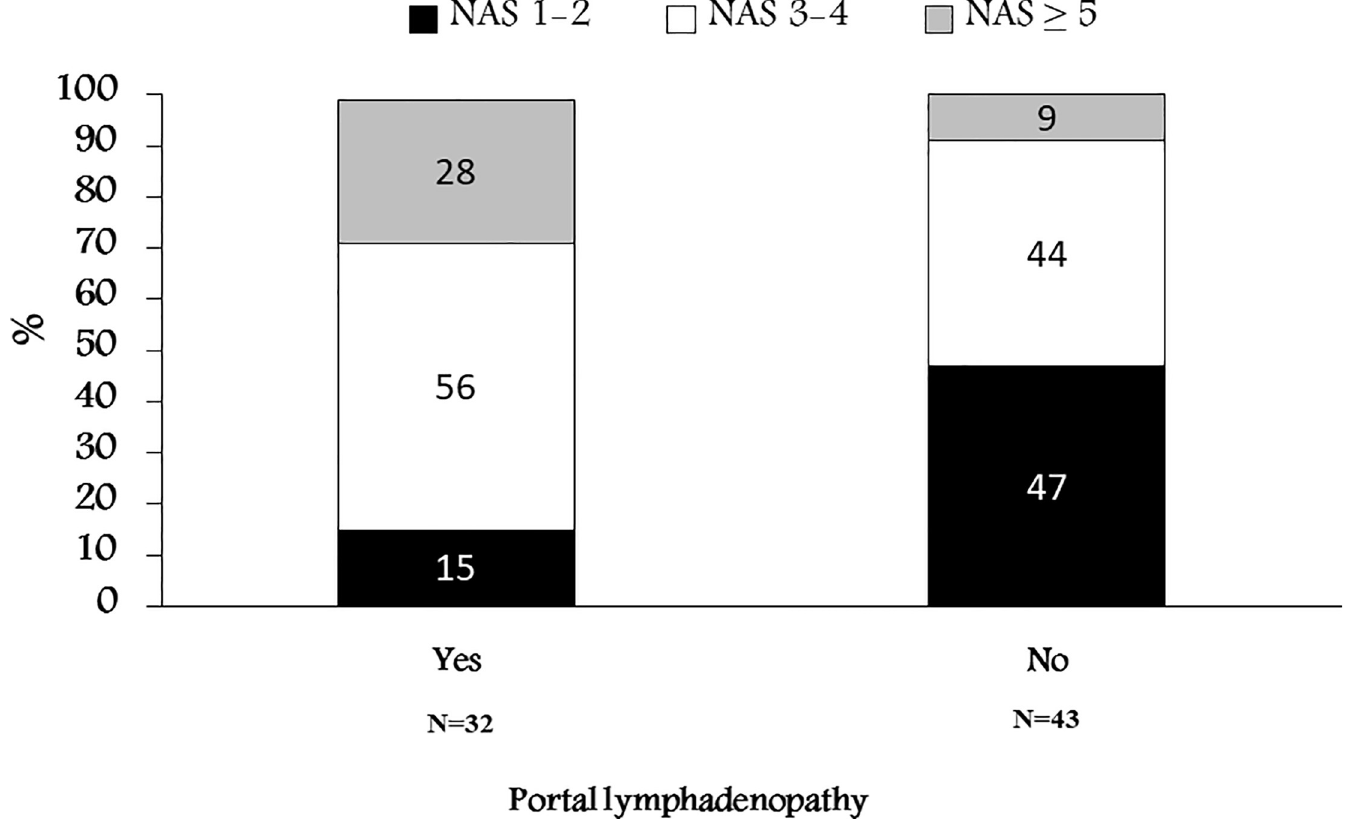
Fig 1. Distribution (%) of NAS according to the status of Portal lymphadenopathy.